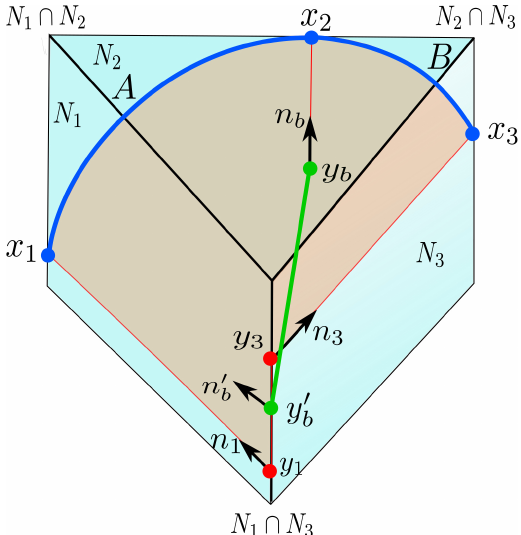
Figure 8: Schematics of the holgraphic construction of extremal EWCS for two adja- cent intervals in a GCF T dual to flat-space 1 + 1